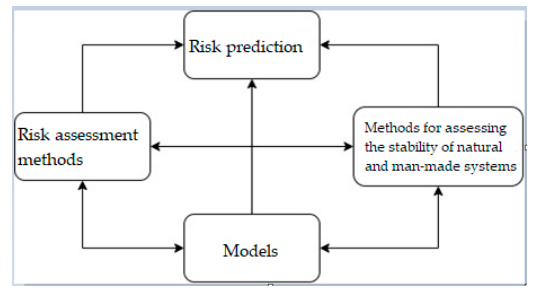
Figure 3. Prediction causal diagram .